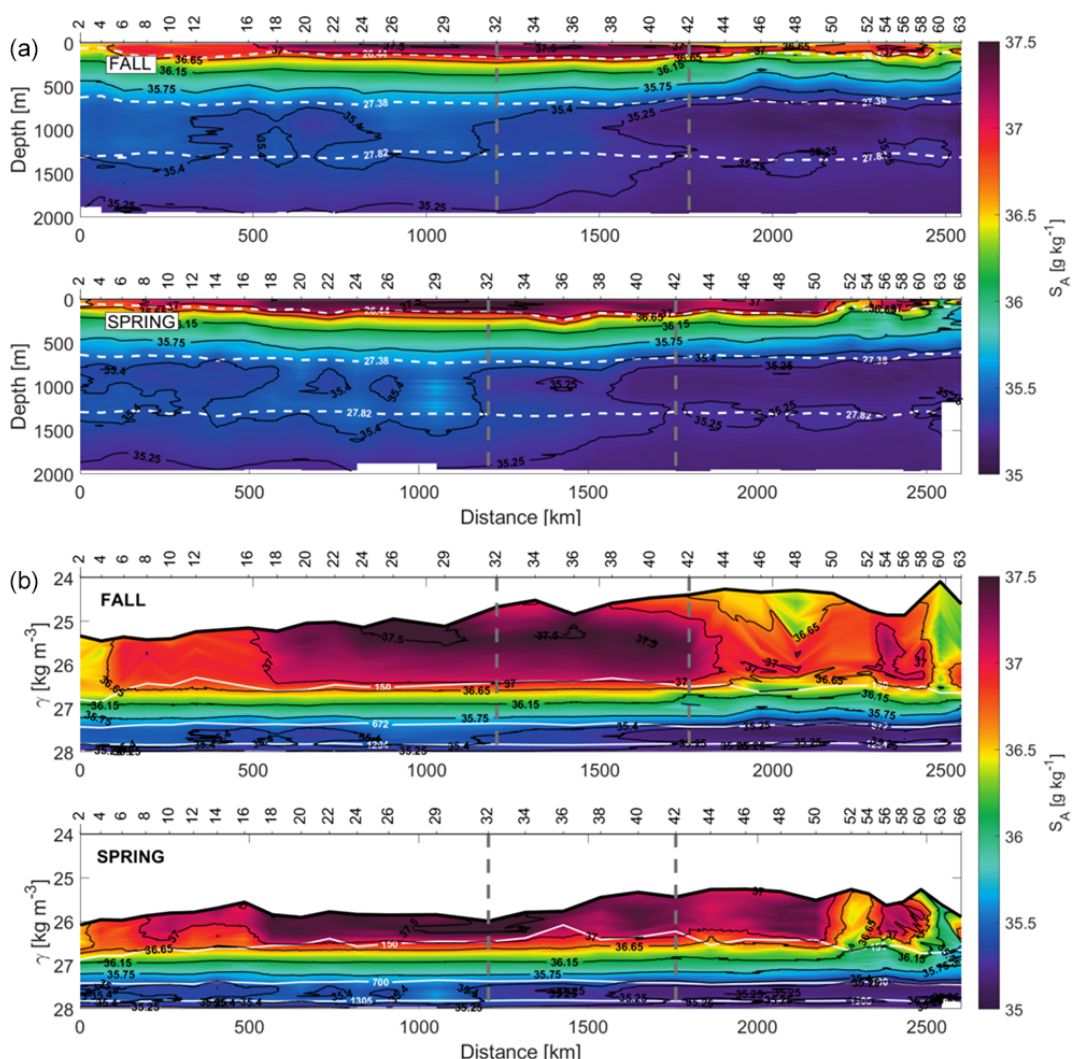
Figure 4. Sections of absolute salinity ( S A ) with respect to depth (a) and γ n (b) during fall and spring. In the depth section in panel (a) , the isoneutrals that delimit the transports at the surface, central, intermediate and deep water are represented by white dashed contours. In the γ n section (b) , the depths of 150, 672–700 and 1294–1305m are also